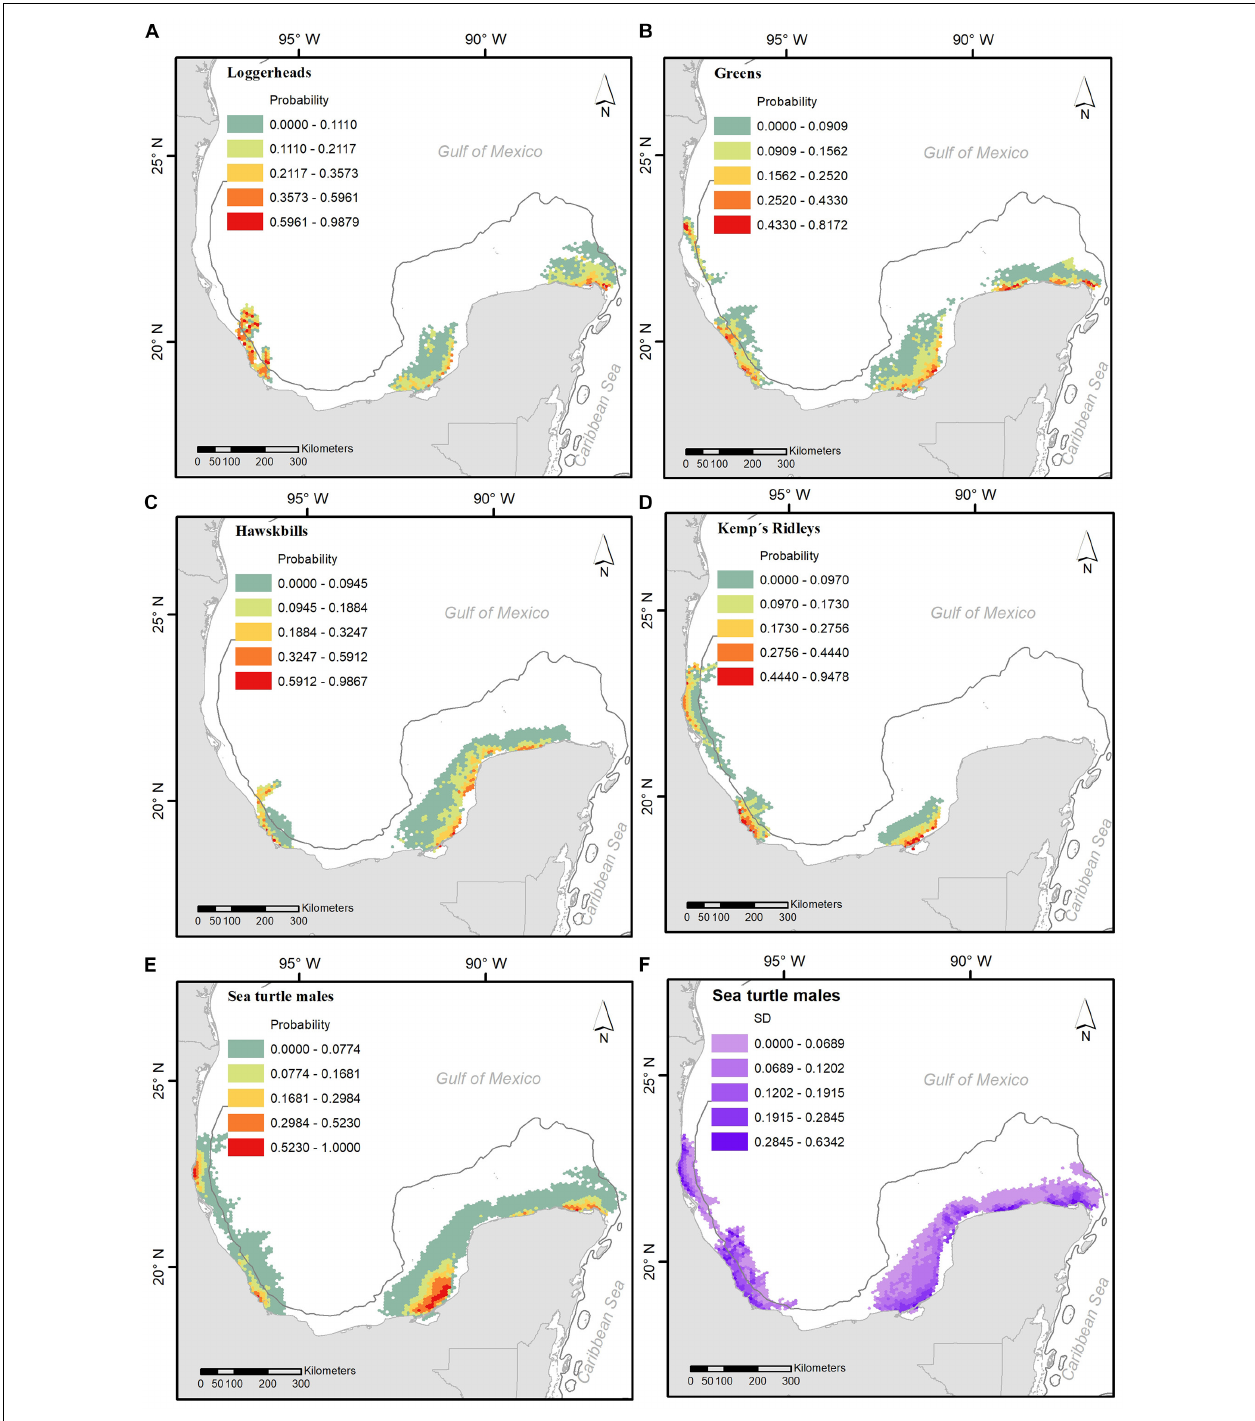
FIGURE 3 | Average probability of death site occurrence for stranding sea turtle males along the coast, for Caretta caretta (A) , Chelonia mydas (B) , Eretmochelys imbricata (C) and Lepidochelys kempii (D) ; and an average of occurrence probability for all species (E) and its standard deviation values (F) .